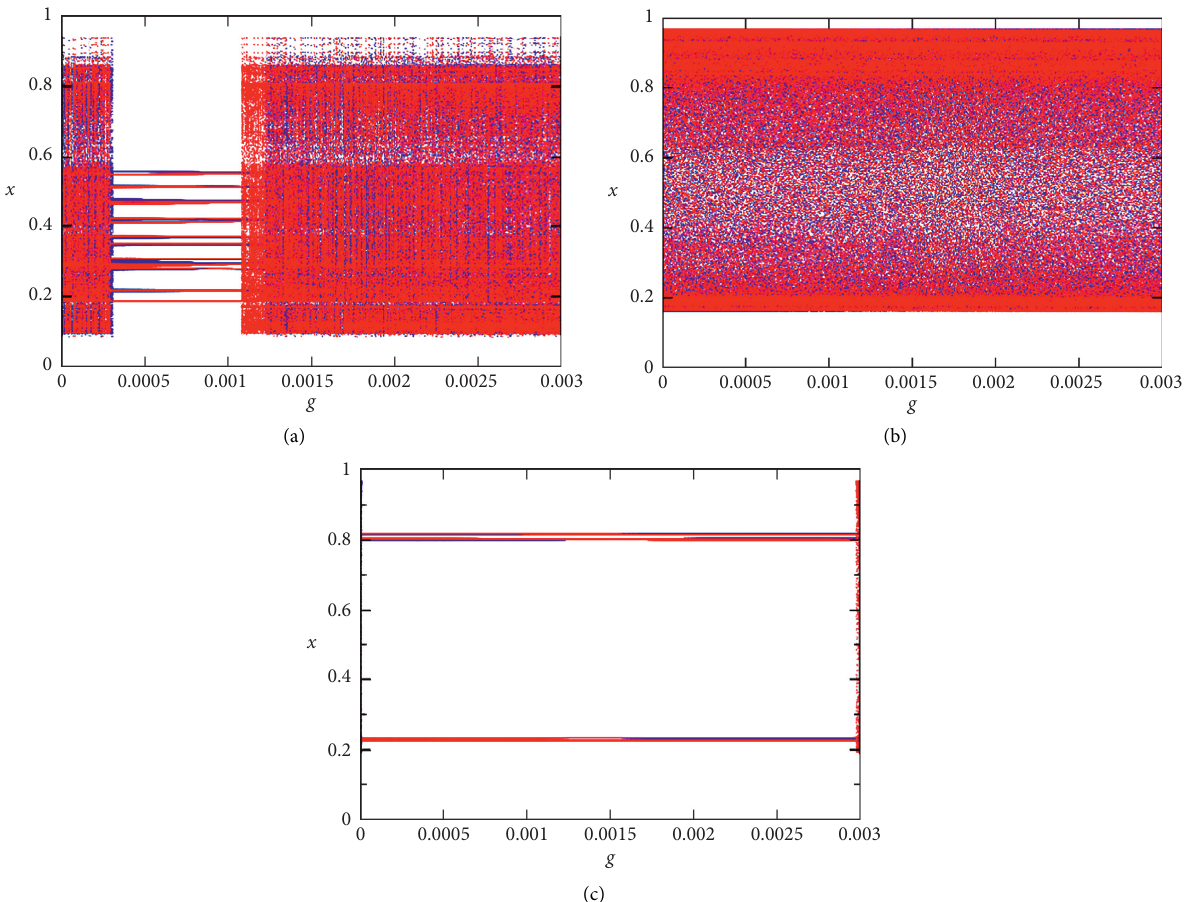
� √ − 1)/2, f � 0.002, and 5